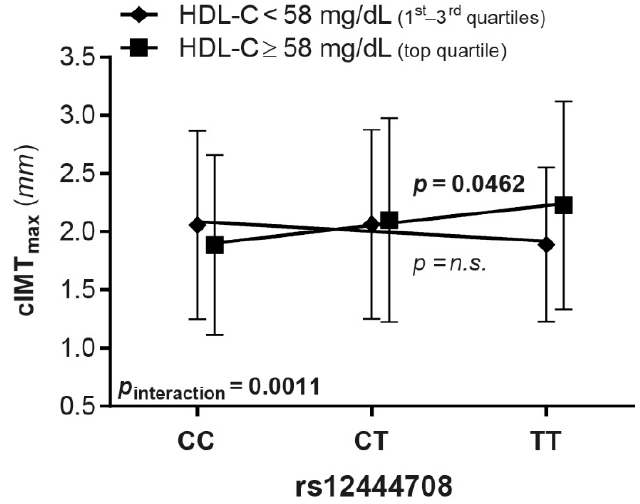
Figure 3. Interaction between the CETP rs12444708 genotype and HDL-C plasma levels in the prediction of cIMT max . This SNP was associated with cIMT max only in patients belonging to the top quartile of HDL-C. The analysis was adjusted as in Figure 2. Abbreviations are the same as those in Figure 1.